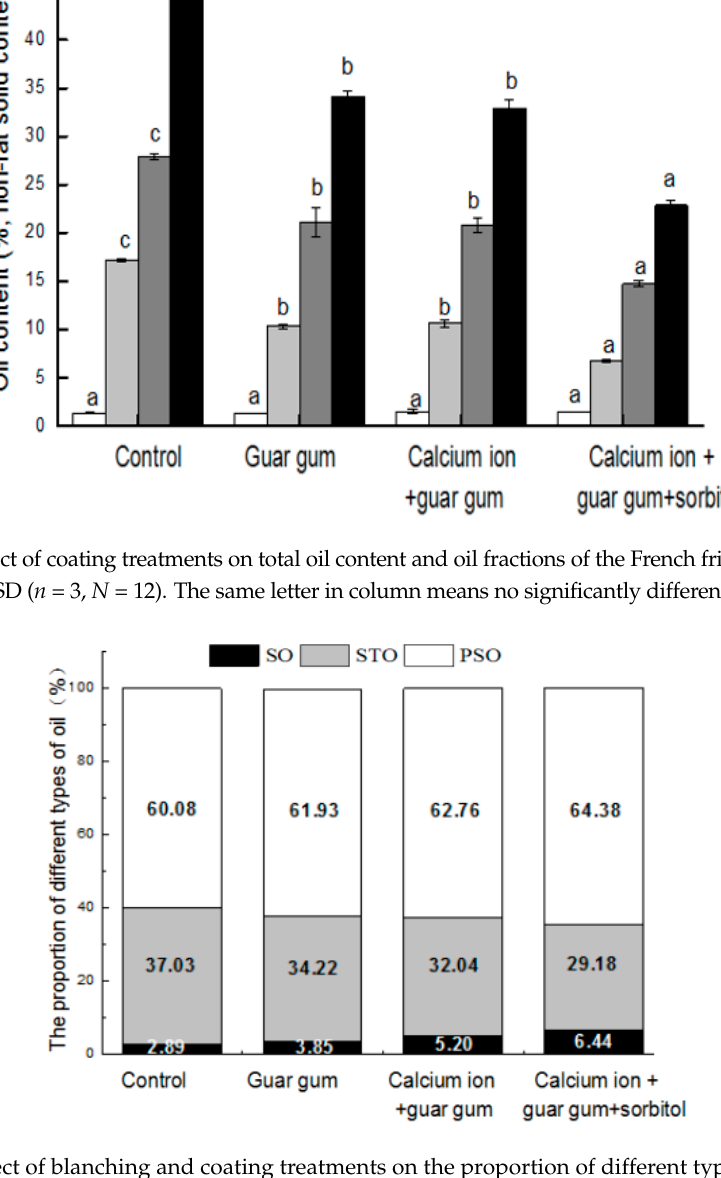
Figure 2. Effect of blanching and coating treatments on the proportion of different types of oil of the French fries.